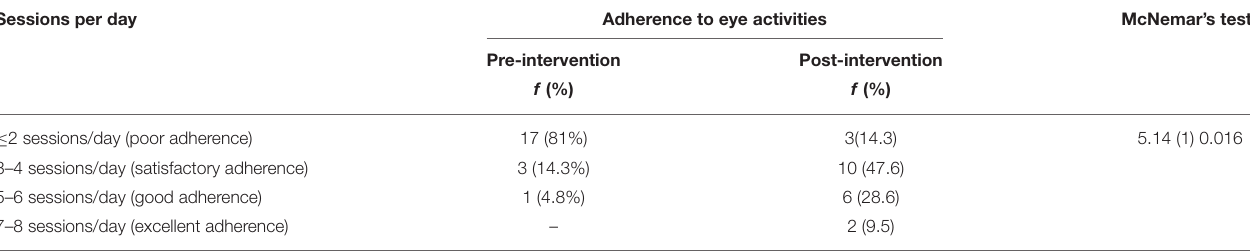
TABLE 5 | Adherence to eye activities during pre-intervention and after 1 month of nurse-led counseling intervention. Sessions per day